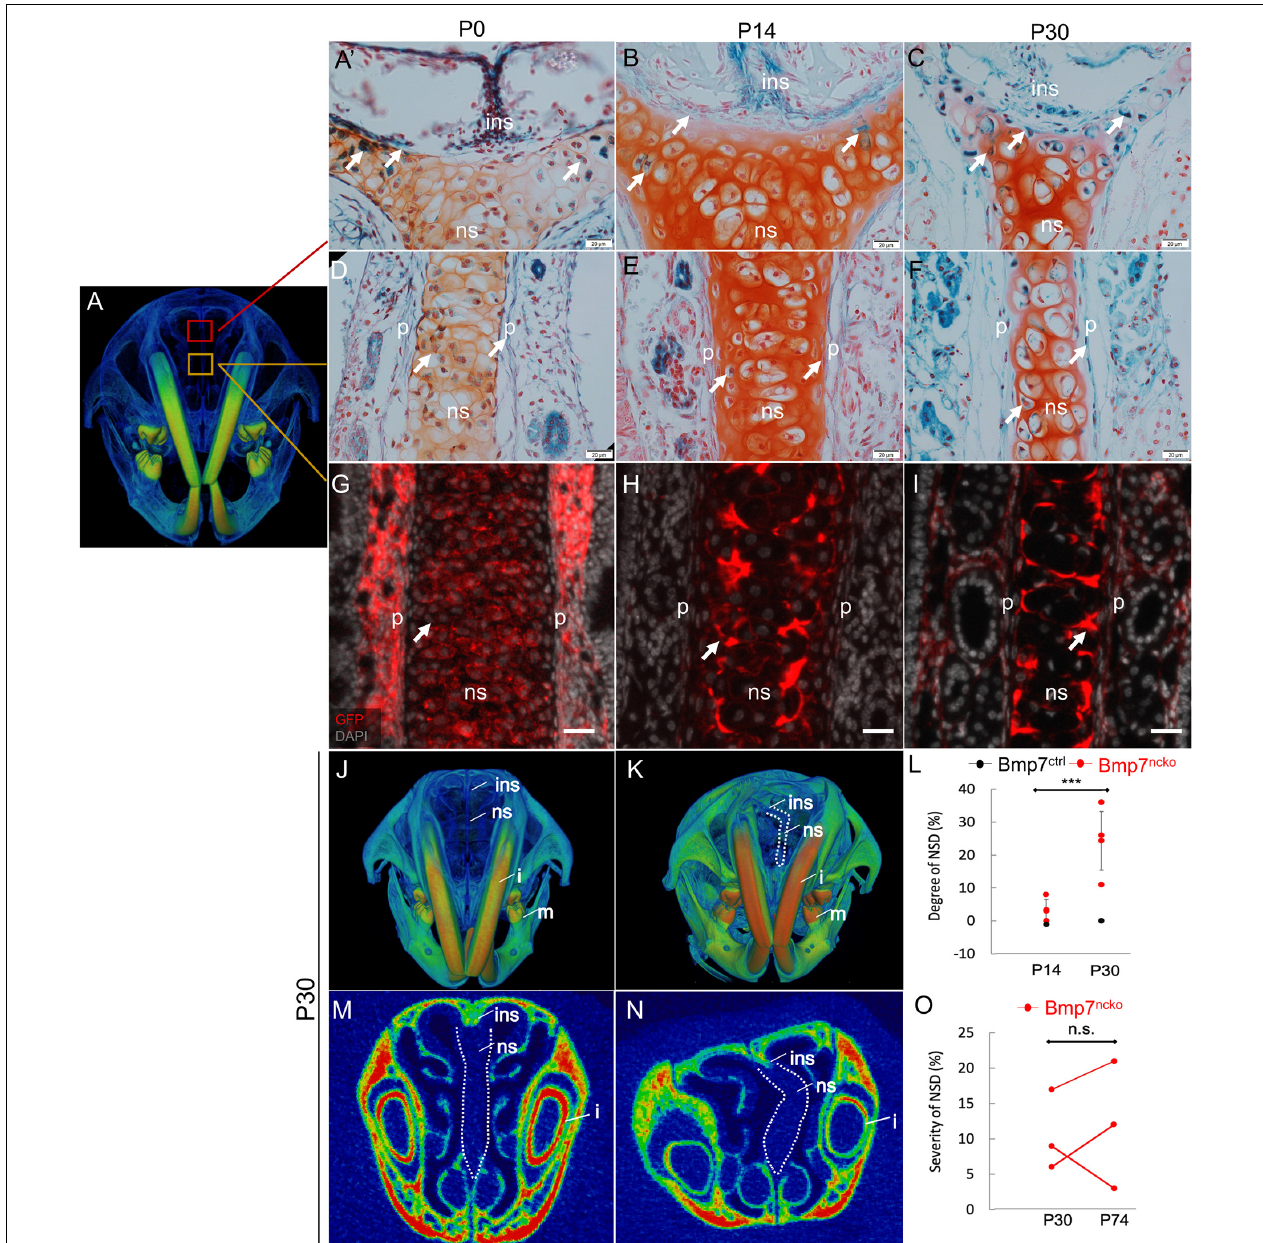
FIGURE 1 | Deletion of BMP7 in neural crest cells results in nasal septum deviation (NSD). (A) µ CT reconstruction of P30 mouse skull demonstrating the location of nasal septum where images were acquired from. LacZ stained (blue) nasal septum paraffin sections demonstrating BMP7 expression in P0 (A’,D) , P14 (B,E) , and P30 (C,F) Bmp7LacZ reporter mice. Neural crest cells in the nasal septum of P0 (G) , P14 (H) , and P30 (I) identified by Green Fluorescent Protein (GFP) (red) antibody. DAPI used to stain nuclei (gray). Scale bar = 50 µ m. 3D frontal view of P30 Bmp7 ctrl (J) and Bmp7 ncko (K) mice demonstrating nasal septum deviation as outlined in white. (L) Quantification of NSD in P14 and P30 mice ( n = 4/genotype/age). 2D frontal cross section of nasal septum in Bmp7 ctrl (M) and Bmp7 ncko (N) mice. (O) Quantification of nasal septum deviation in Bmp7 ncko mice over time ( n = 3/age). Data points represent individual mice with error bars demonstrating biological variation. ins, internasal suture; ns, nasal septum; p, perichondrium; i, incisor; m, mandible. P14, postnatal day 14; P30, postnatal day 30; P74, postnatal day 74. *** p < 0.001, two-tailed independent t -test. n.s., not significant. Scale bar (A–F) : 20 µ m and (G,H) : 50 µ